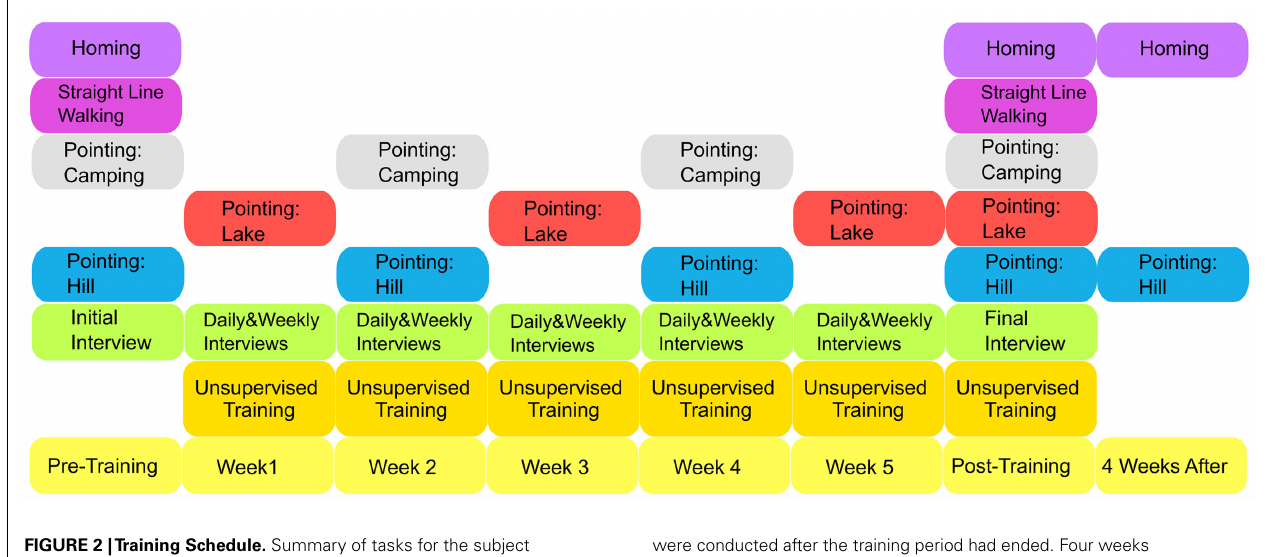
FIGURE 2 |Training Schedule. Summary of tasks for the subject during the 6-weeks of the study. Pre-training experiments were conducted prior to training with the belt, post-training experiments